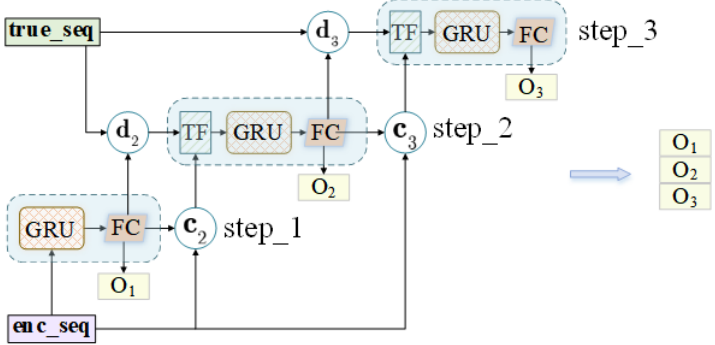
Figure 14. The hierarchical TL network module interacting with